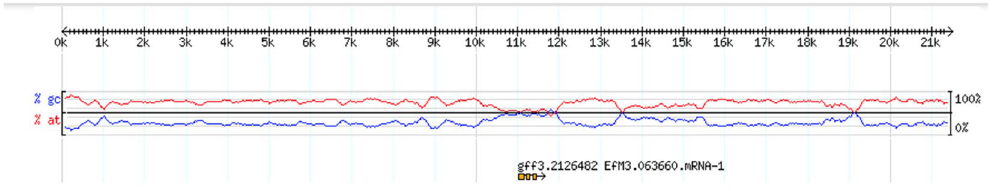
Figure 11. Efe - afpA is the only gene on a genome sequence contig consisting mainly of repeated sequences. Screenshot of E . festucae E2368 supercontig 268 from the Epichloë festucae Genome Project website 5 (http://